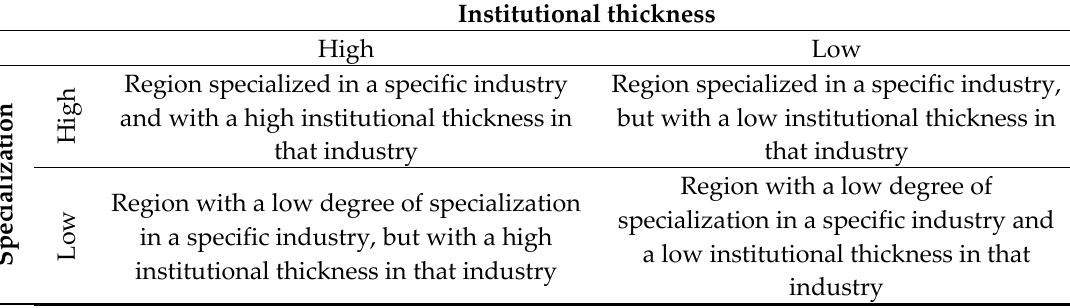
Figure 1. Specialization-institutional thickness.